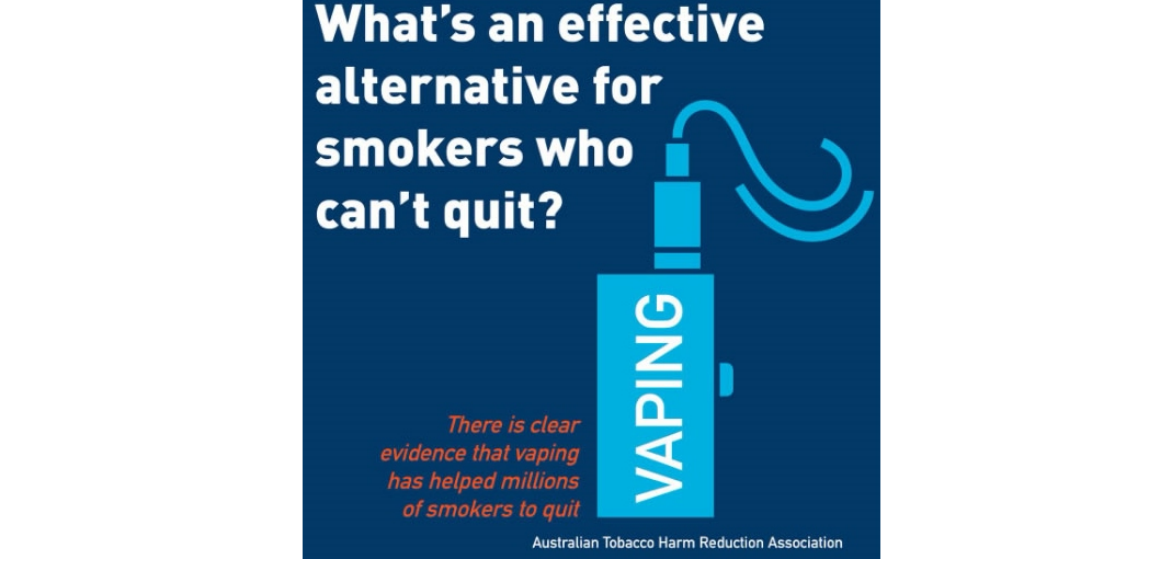
Only 1.92% (25/1303) of posts contained a health warning